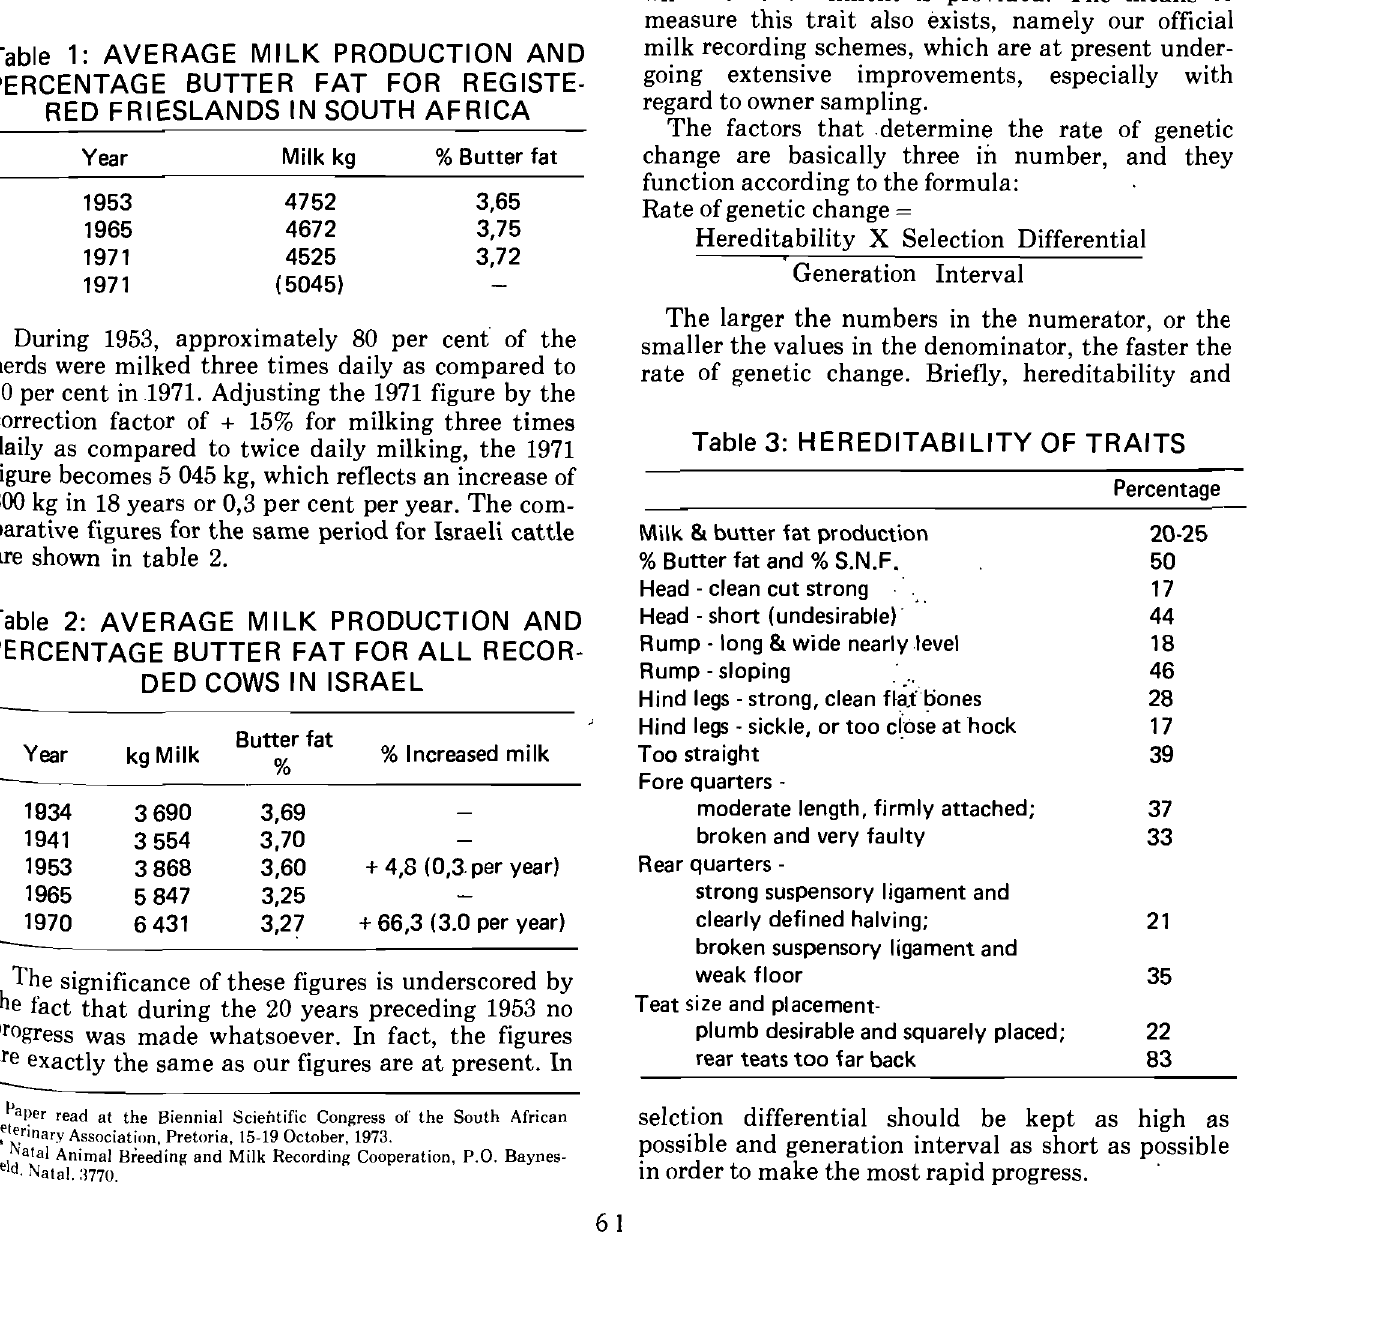
Table 3: HEREDITABILITY OF TRAITS